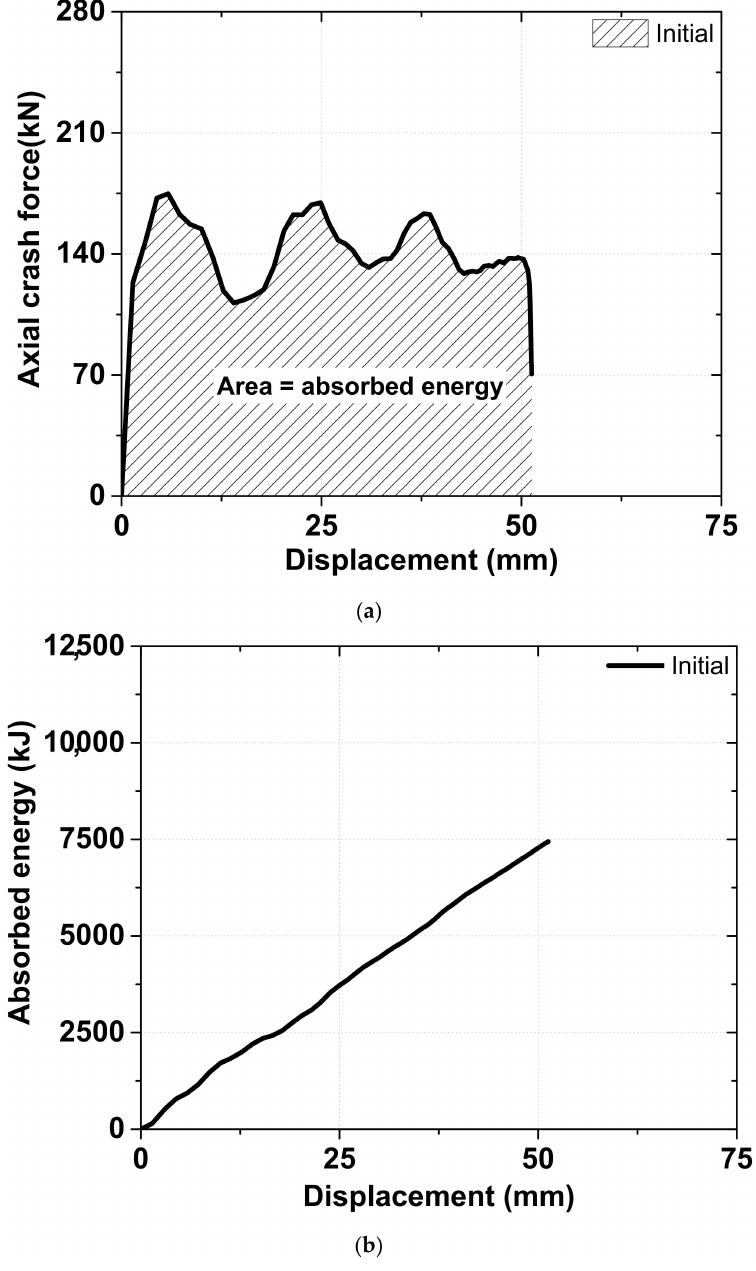
Figure 6. An example of the absorbed energy calculation method using the initial specimen: ( a ) integration area for calculating absorbed energy; ( b ) absorbed energy with respect to